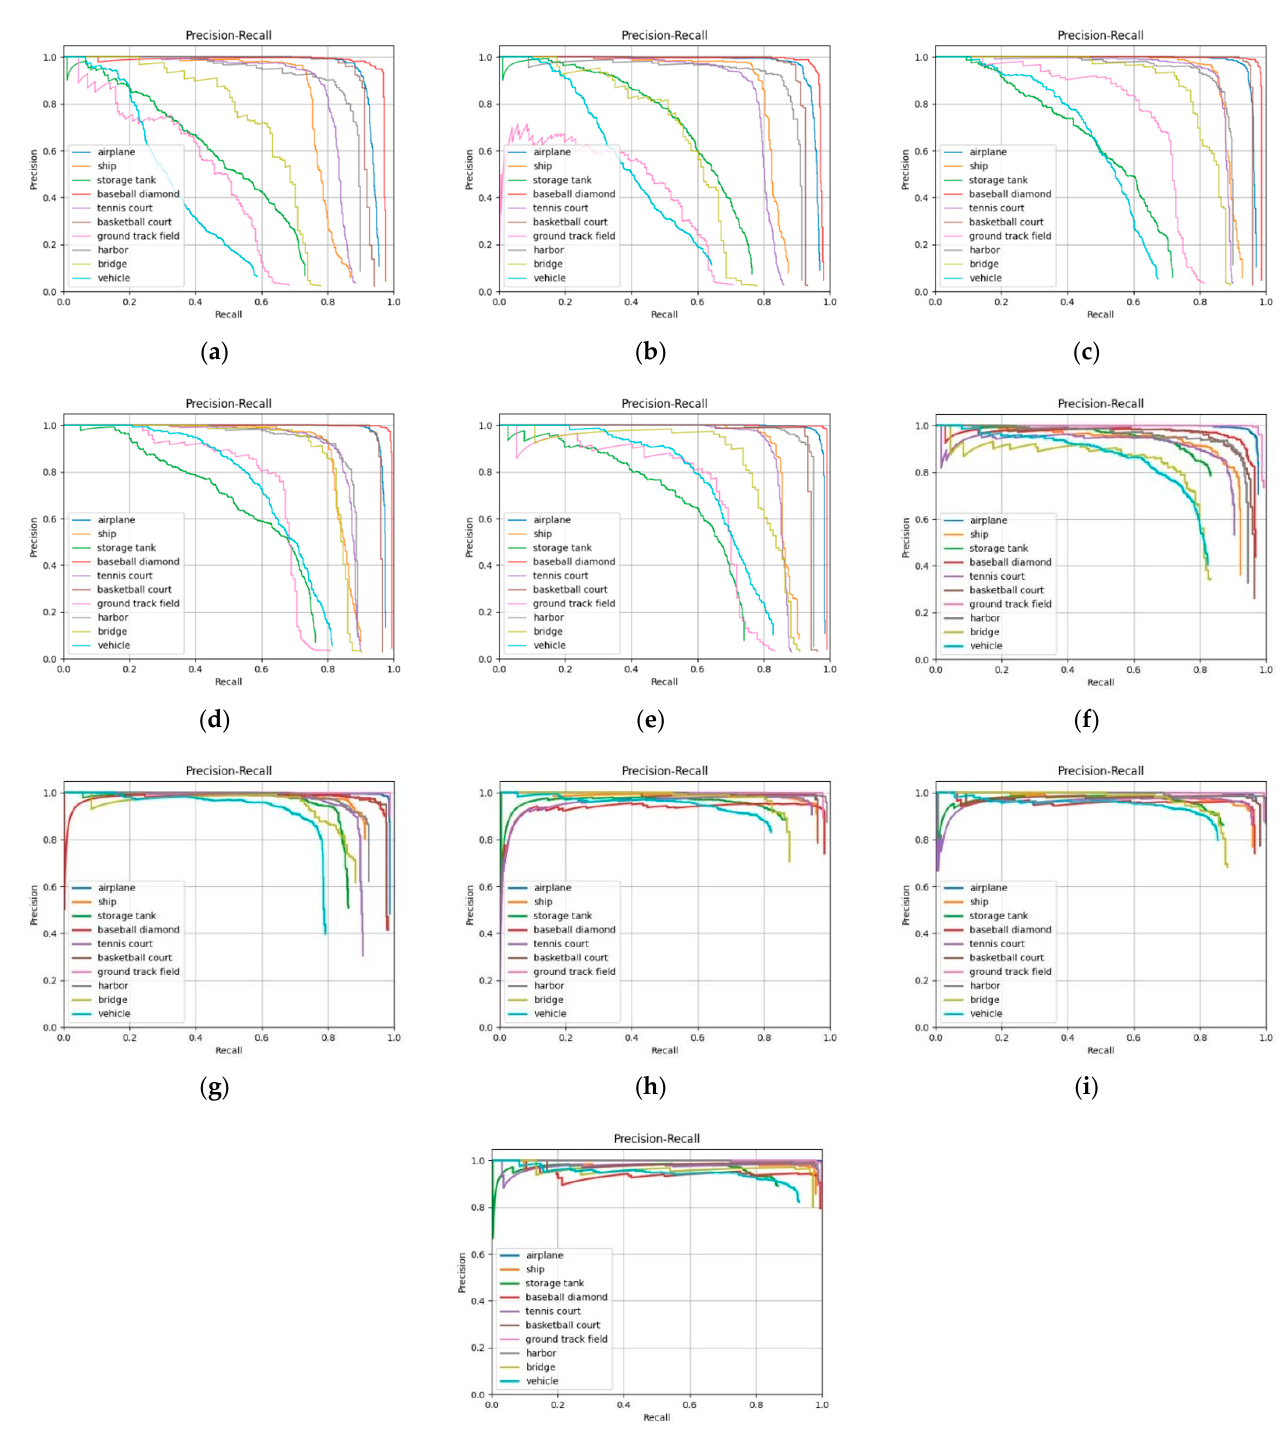
Figure 10. The P-R curves of different frameworks with the NWPU VHR-10 dataset. ( a ) Faster- RCNN; ( b ) YOLO; ( c ) SSD; ( d ) RICNN; ( e ) R-P-Faster-RCNN; ( f ) Def. R-FCN; ( g ) Def. Faster-RCNN; ( h ) RICADet; ( i ) Multi-Scale CNN; ( j ) Multi-stage